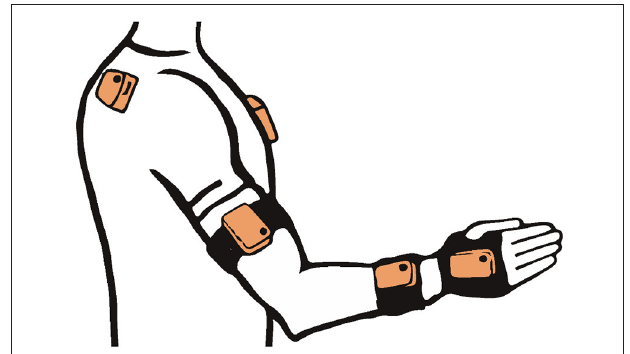
FIGURE 1 | Measurement system